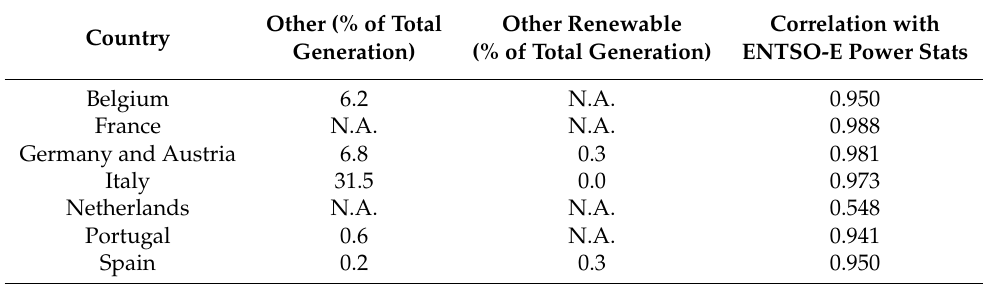
Table A1. Shares of other categories and correlation transparency and power statistics ENTSO-E [55,58]. Other (% of Total Other Renewable Correlation with Country Generation) (% of Total Generation) ENTSO-E Power Stats Belgium 6.2 N.A. 0.950 France N.A. N.A. 0.988 Germany and Austria 6.8 0.3 0.981 Italy 31.5 0.0 0.973 Netherlands N.A. N.A. 0.548 Portugal 0.6 N.A. 0.941 Spain 0.2 0.3